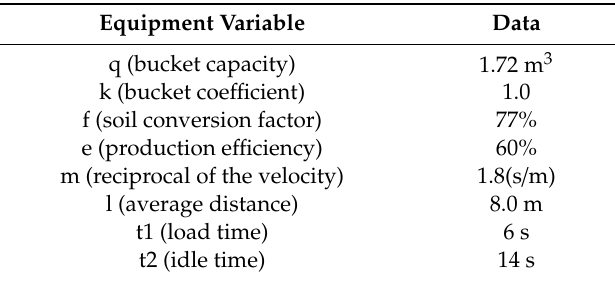
Table 4. Wheel loader variable